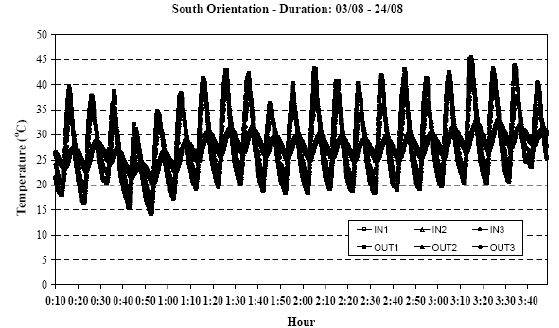
becomes quite cool so as to be able to absorb again the undesired heat. The same behavior is noticed from the re- sults of all test room orientations. In Fig. 14 temperature curves for a typical summer week and for south orienta- tion are presented confirming the same behavior that was discussed above.